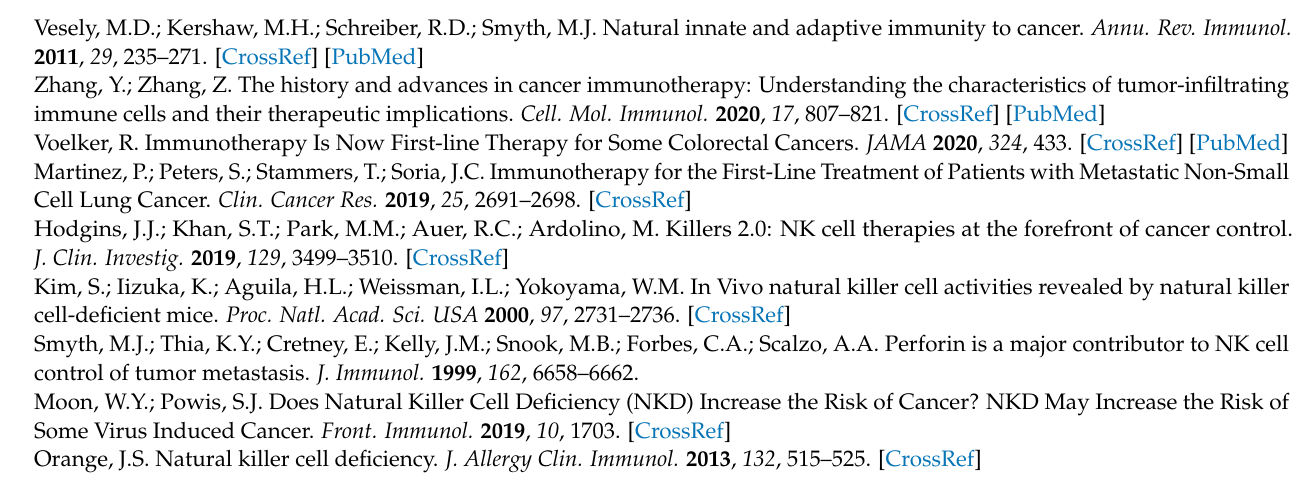
Figure S2: generation of K562-NL; Figure S3: Colistin failed to improve NK cell cytotoxicity Table S1: Fold-change of NK92 and K562-NL cells treated with compounds from the Prestwick Chemical Library drug screening, Table S2: Compounds of the Prestwick Chemical Library excluded from analysis, Table S3: Z (cid:48) factor for individual assay plates from the screening of the Prestwick Chemical